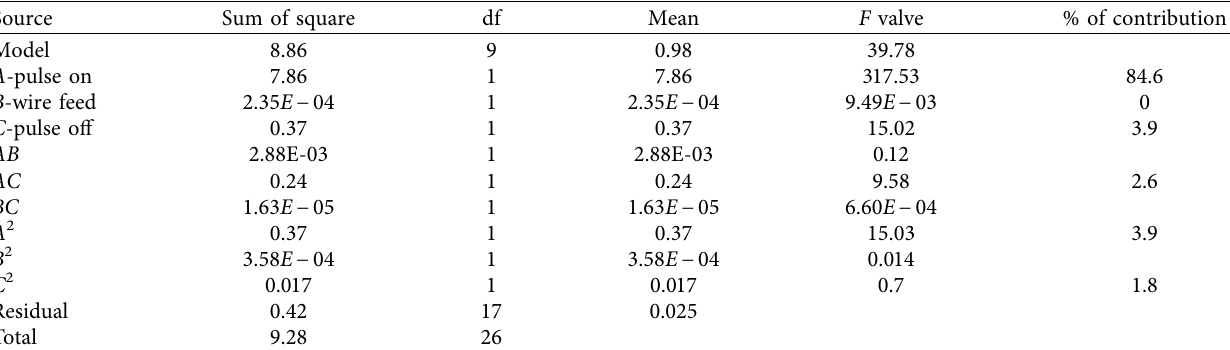
Table 11: ANOVA for surface